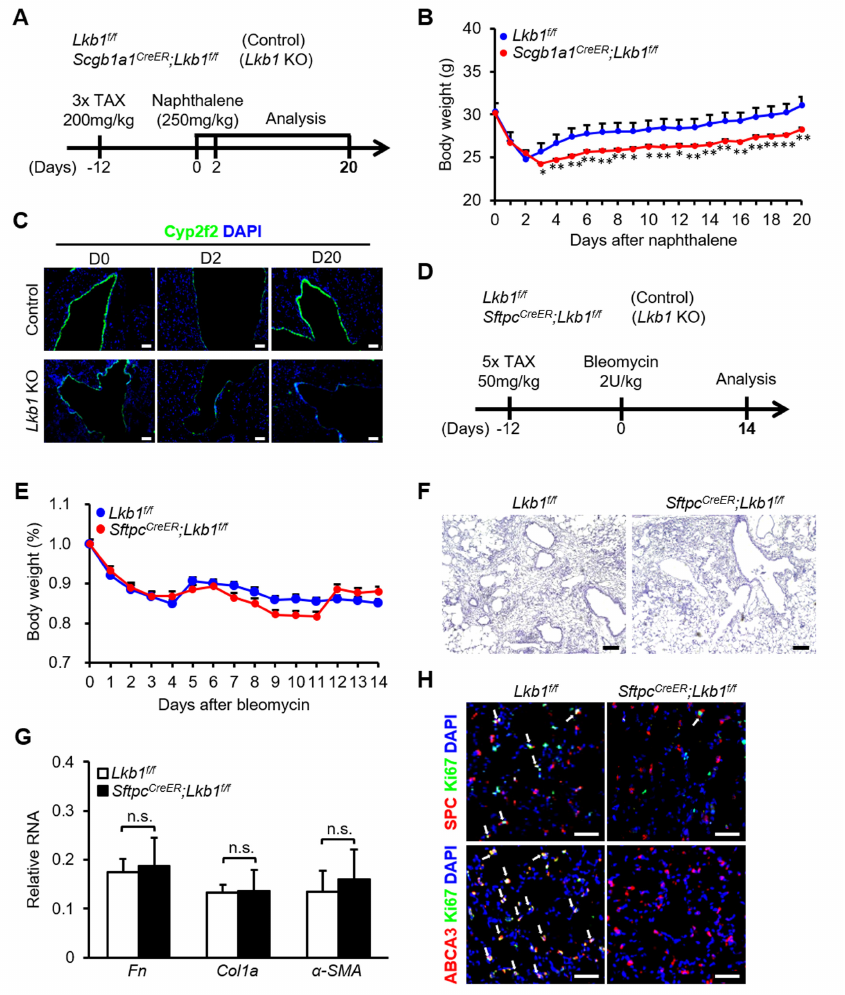
Figure 4. Lkb1 is beneficial for the recovery of the lung epithelium after injury. ( A ) Naphthalene (250 mg/kg) was injected intraperitoneally to induce airway injury in Lkb1 f/f mice and Scgb1a1 CreER ; Lkb1 f/f mice and lung tissues were collected on days 0, 2, and 20 after injury (n = 10). ( B ) Body weight was analyzed after naphthalene treatment (n = 10). ( C ) Representative images showing the extent of club-